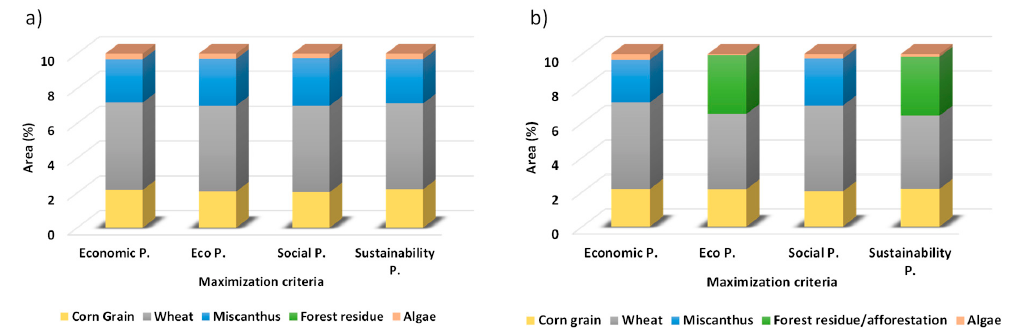
Figure 7. Usage of the area when applying different maximization criteria for ( a ) third and ( b ) fourth scenario.